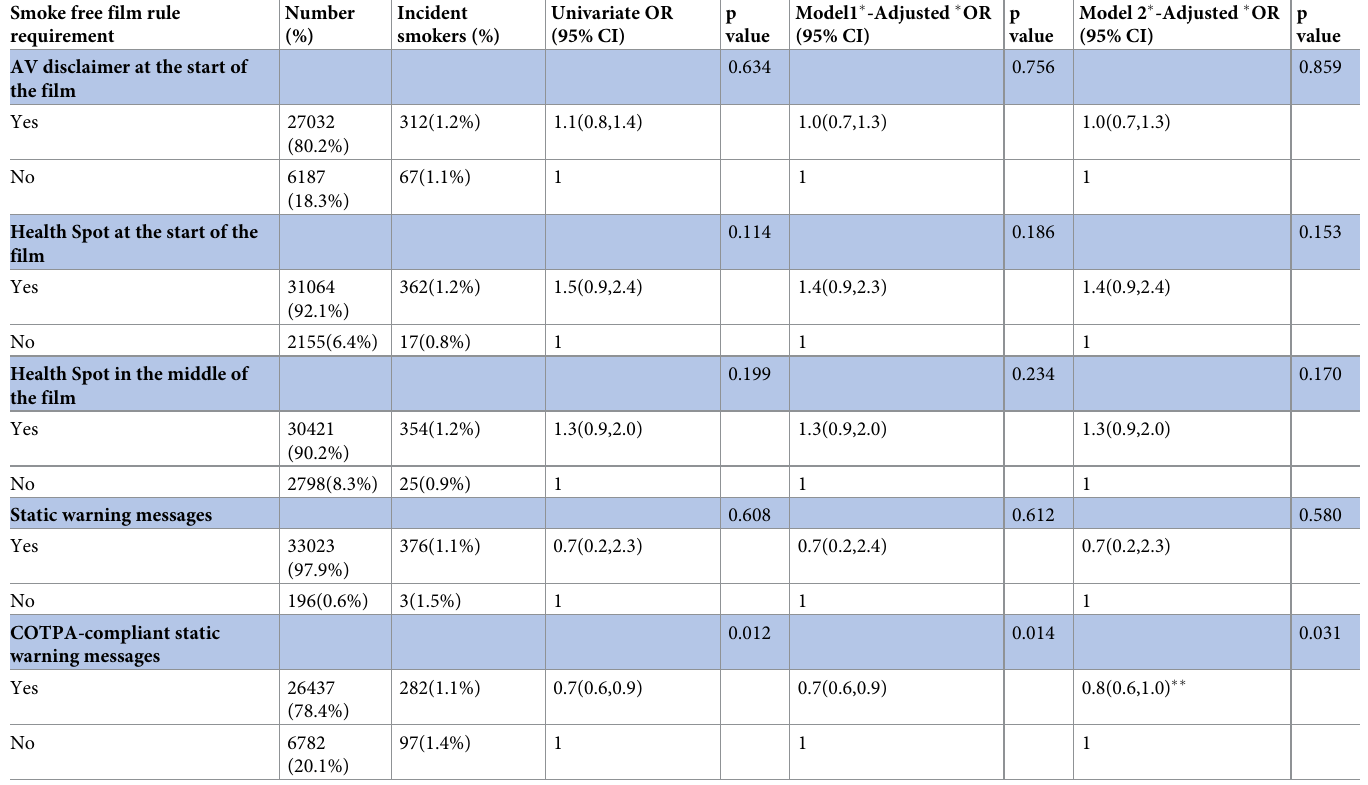
Table 2. Effect of tobacco free film rules on incident smoking, added to the mutually adjusted model in Table 1 in place of film tobacco variables, graded according to whether the film contained audio-visual disclaimers, health spots and static warning messages either in any form or in form compliant with legal requirements. Smoke free film rule